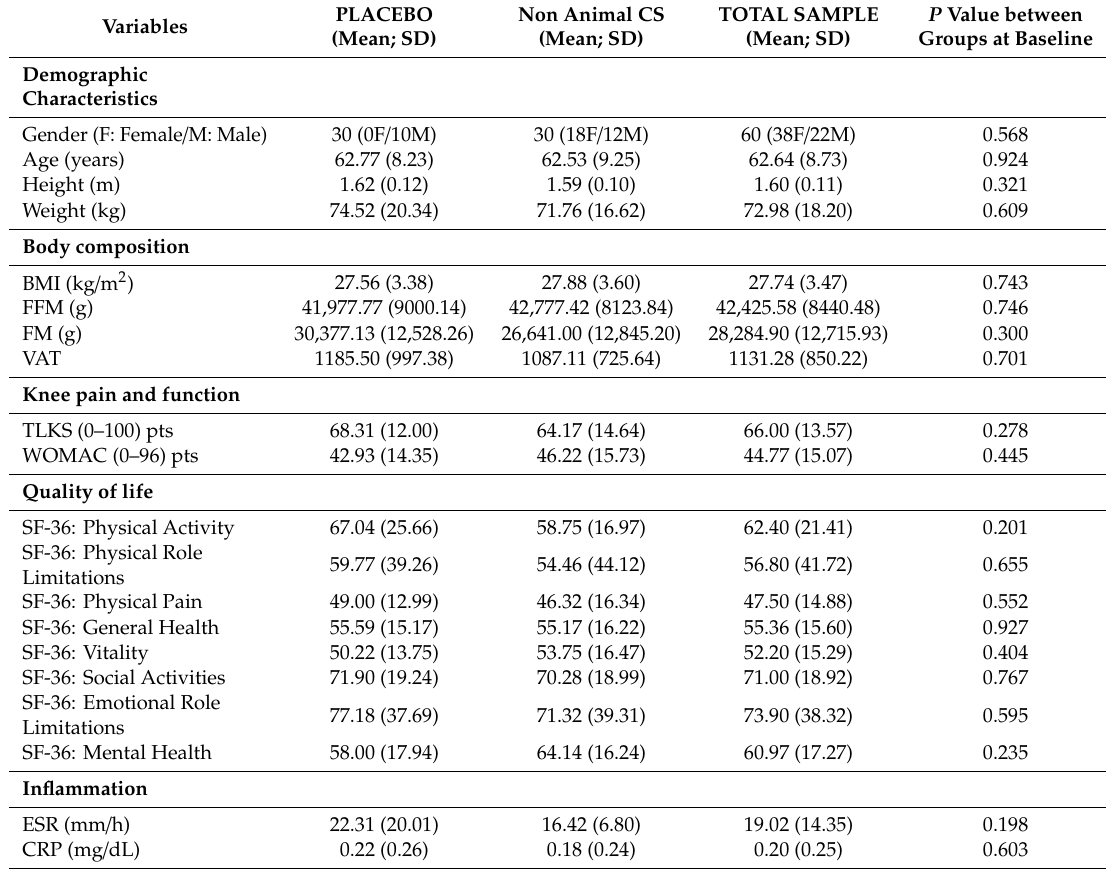
Table 2. Descriptive statistics of the sample at